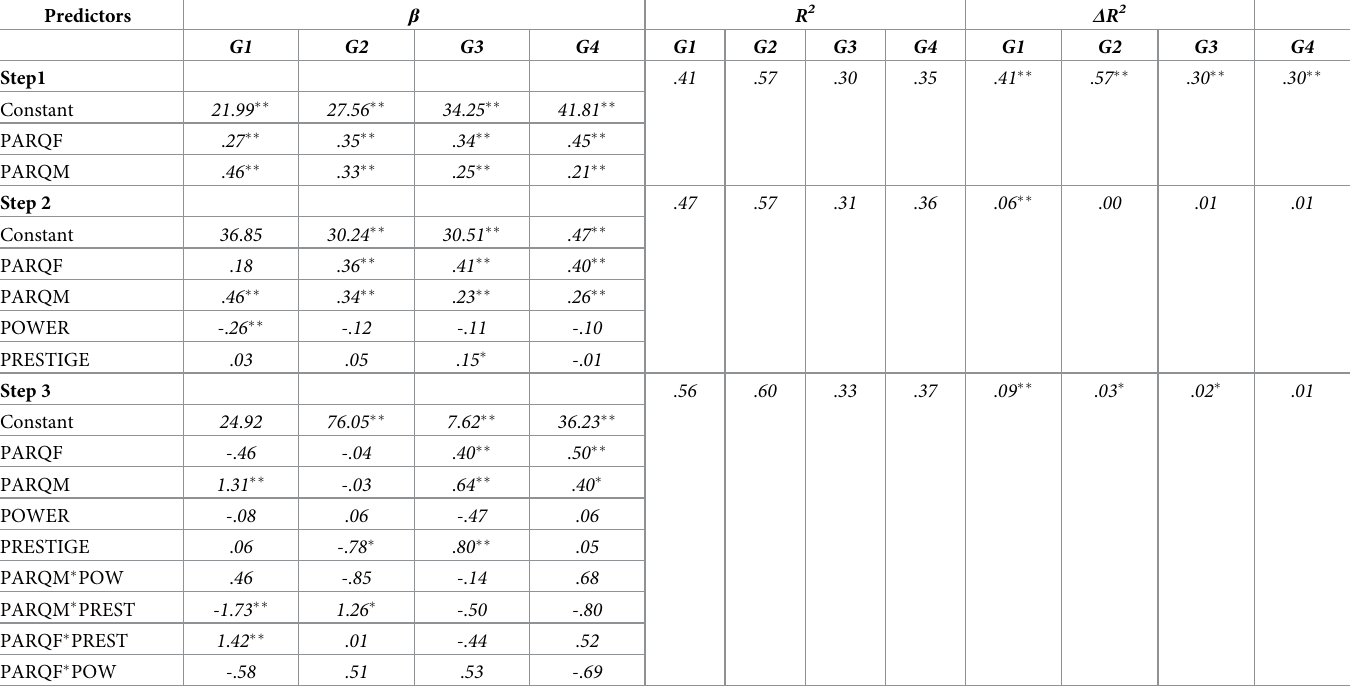
Table 3. Hierarchical regression analyses predicting children’s psychological adjustment by age